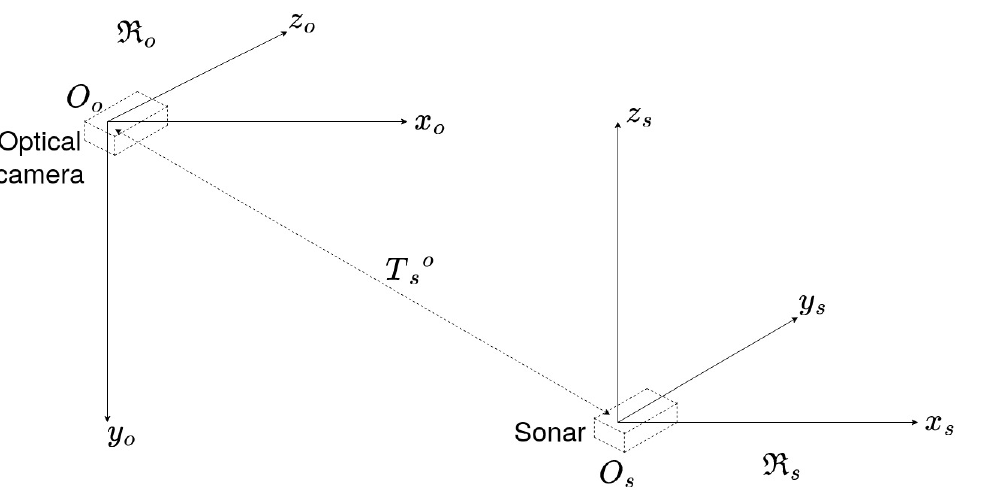
Figure 3. The camera frame R o , the sonar frame R s , and the translation vector T o s